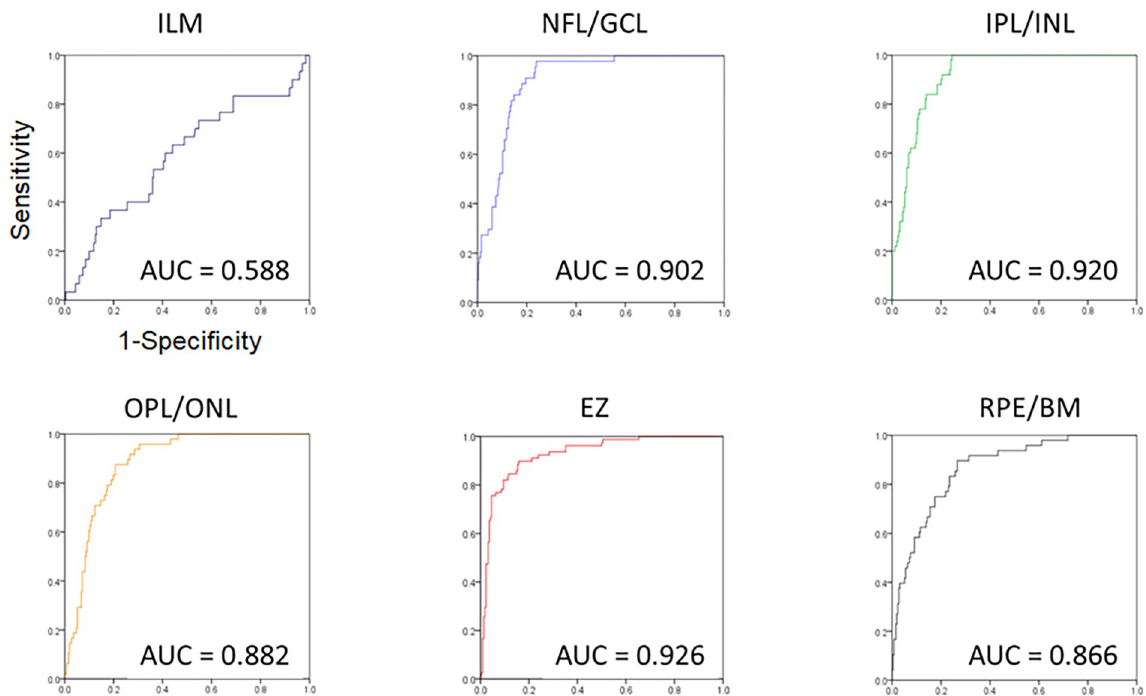
Fig 6. Ambiguity index distribution map. Blue: Normal Amb-I distribution map; Red: Abnormal Amb-I distribution map. It was observed that IPL/INL and EZ can be classified with high accuracy.